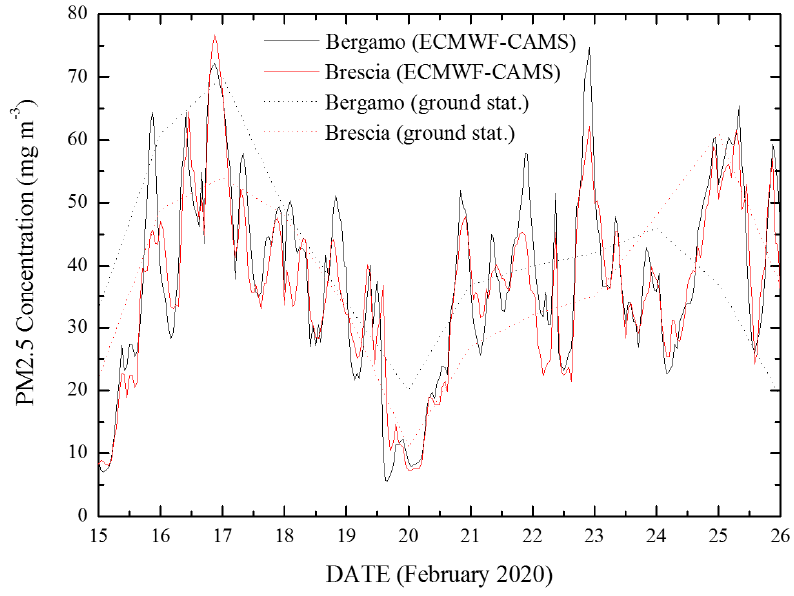
Figure 1. Particulate matter (PM 2.5 ) concentration levels over the period 15–26 February 2020 as measured by the two ground stations in Bergamo (via Meucci, 45°41 ′ 24 ′′ N, 09°38 ′ 28 ′′ E) and Brescia (Villaggio Sereno, 45°31 ′ 04 ′′ N, 10°10 ′ 41 ′′ E), together with the data from near-real-time European Centre for Medium-Range Weather Forecasts (ECMWF)–Copernicus Atmosphere Monitoring Service (CAMS) analysis.